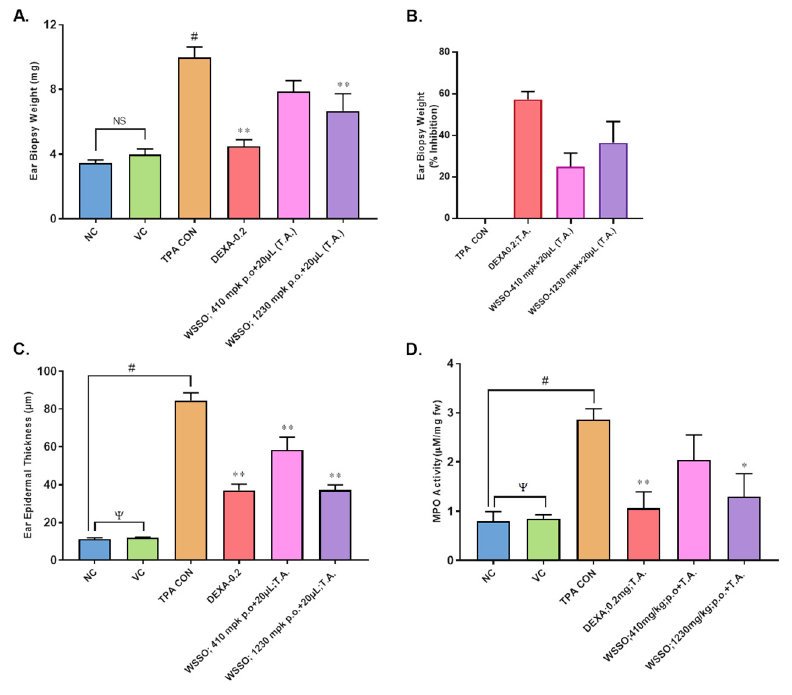
Figure 5. WSSO decreases TPA-induced inflammation and myeloperoxidase (MPO) activity in the ear